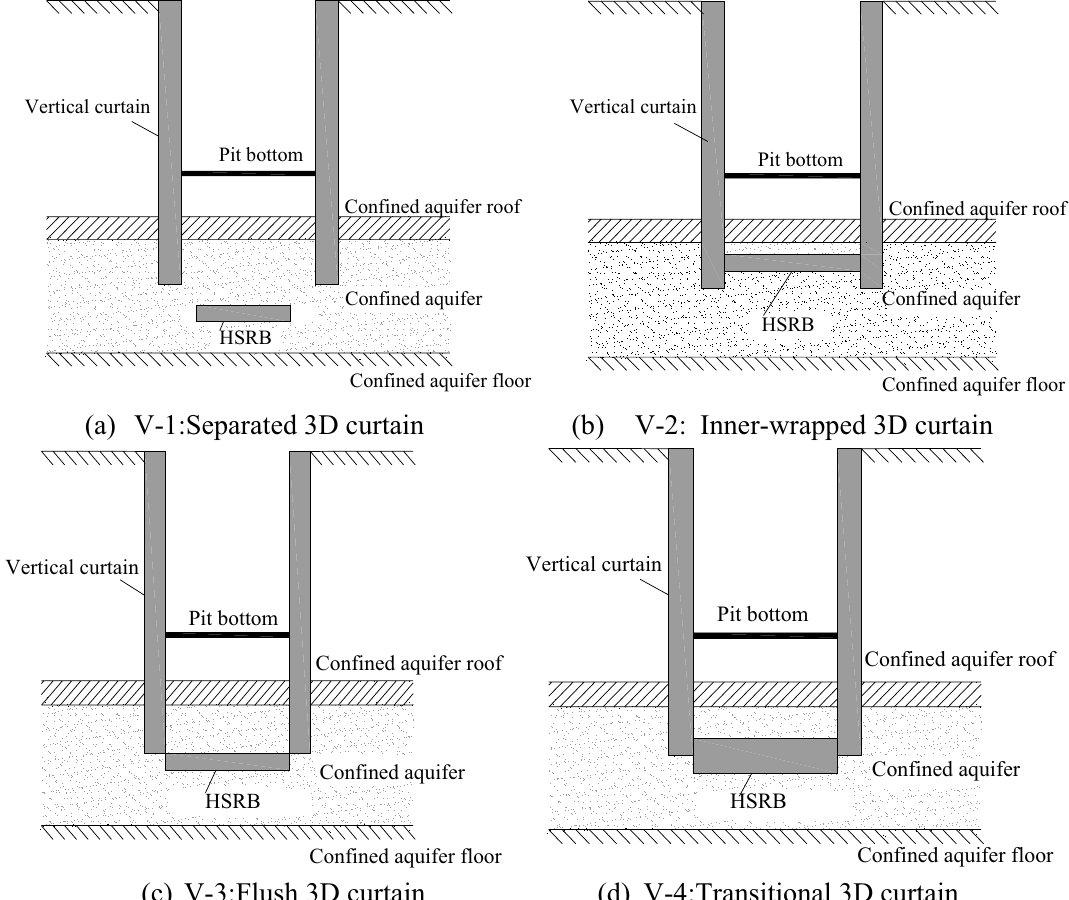
Figure 17. Combination sub-mode of vertical curtain and